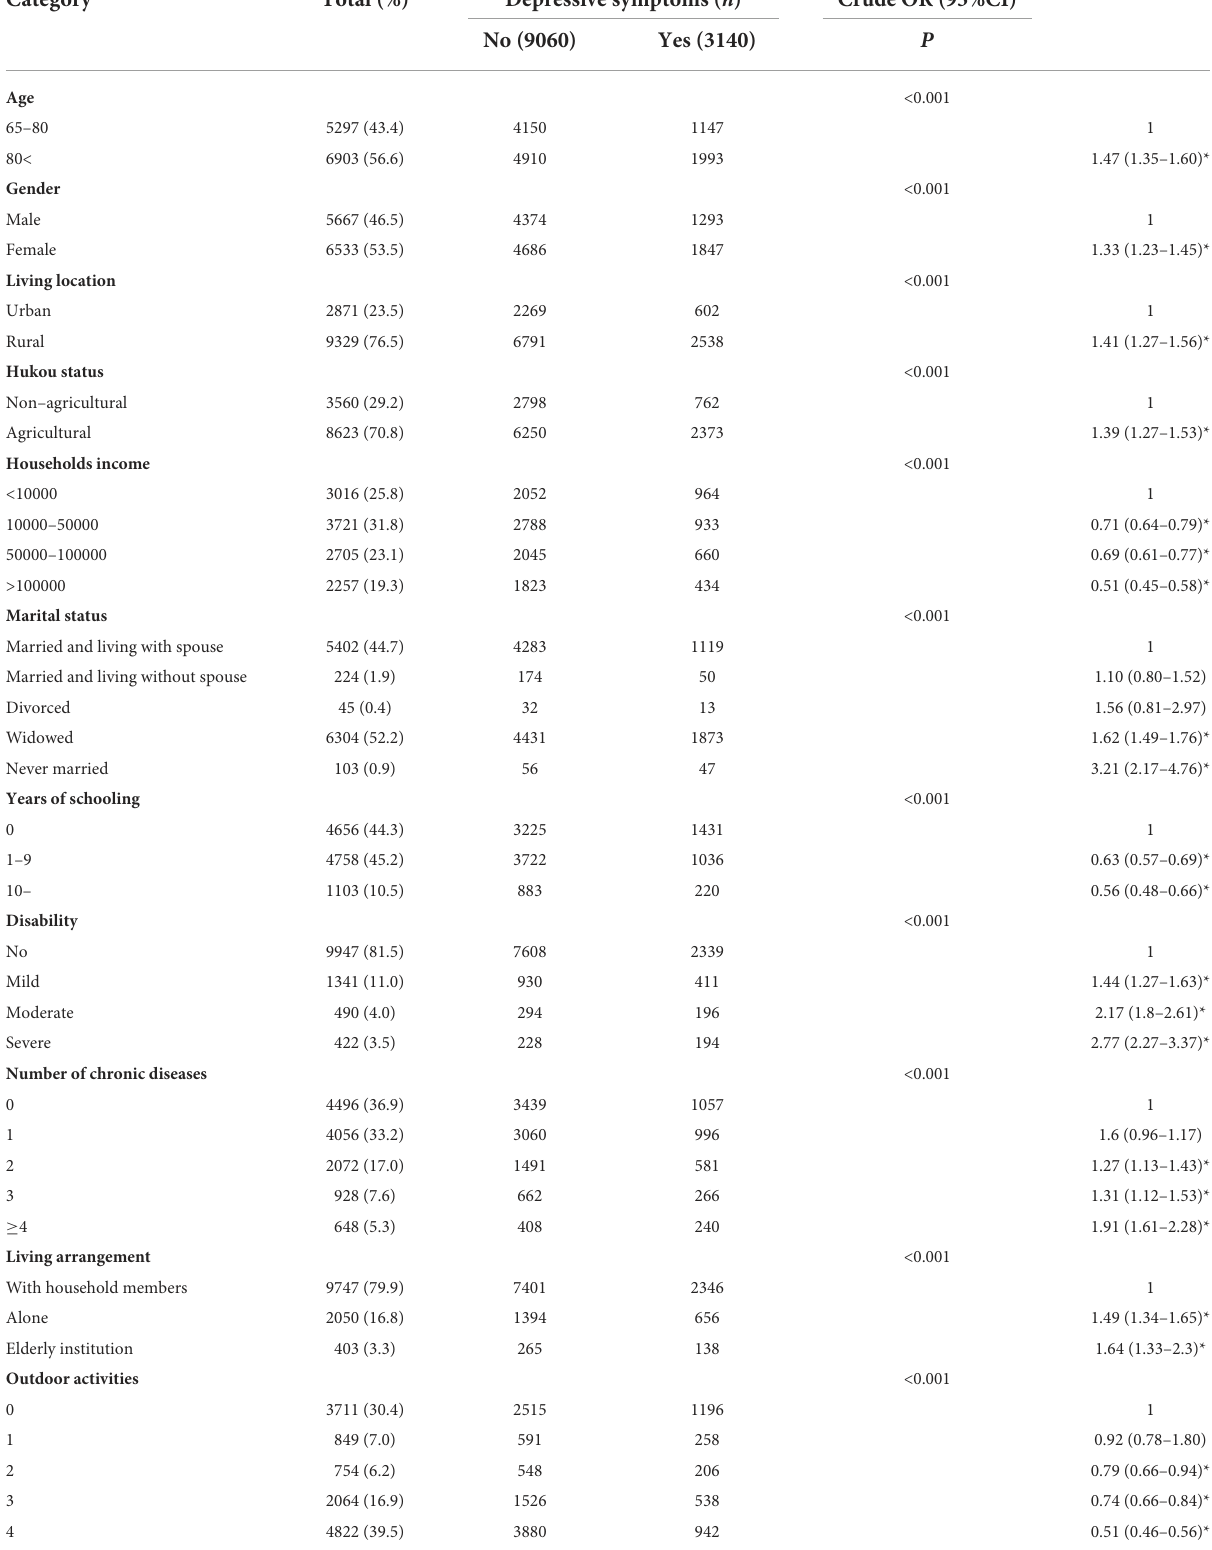
TABLE 1 General characteristics of the participants by the occurrence of depressive symptoms and their unadjusted odds